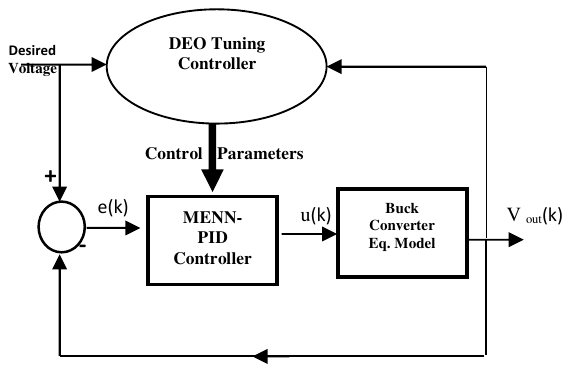
Fig. 2. The structure of MENN-PID controller for Buck converter equation model.